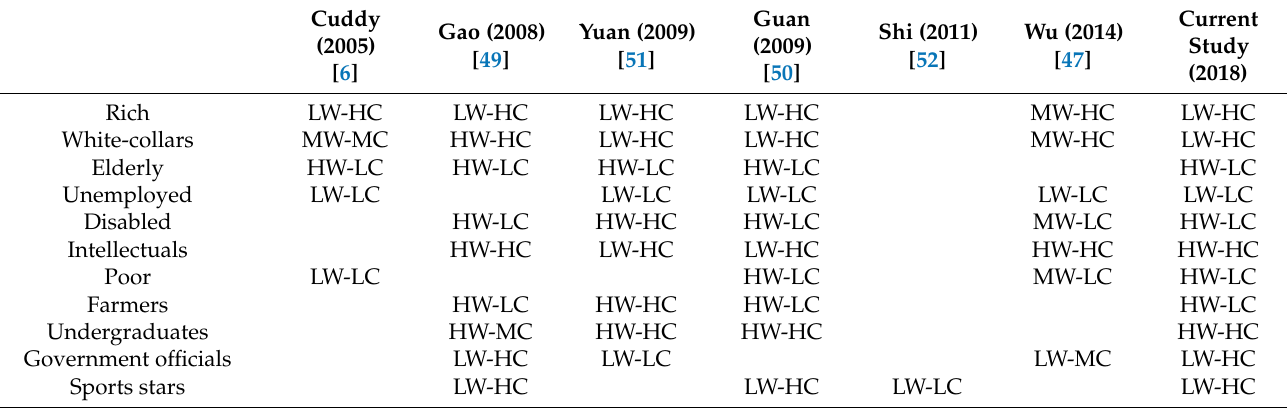
Table 8. Classical social groups and their SCM quadrants in